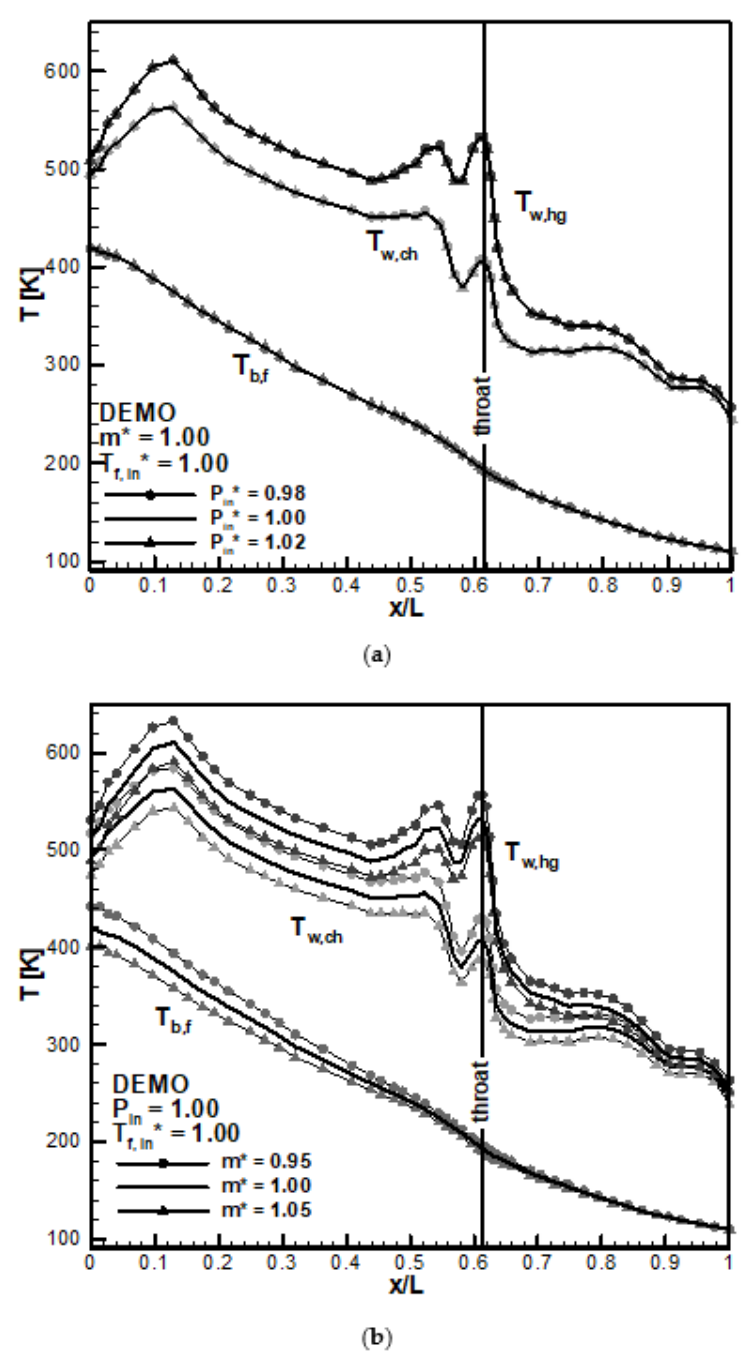
Figure 18. Axial profiles of hot-gas-wall temperature, temperature of channel bottom surface, and fluid bulk temperature (runs 1, 5-8): ( a ) effects of inlet pressure; ( b ) effects of mass-flow rate.